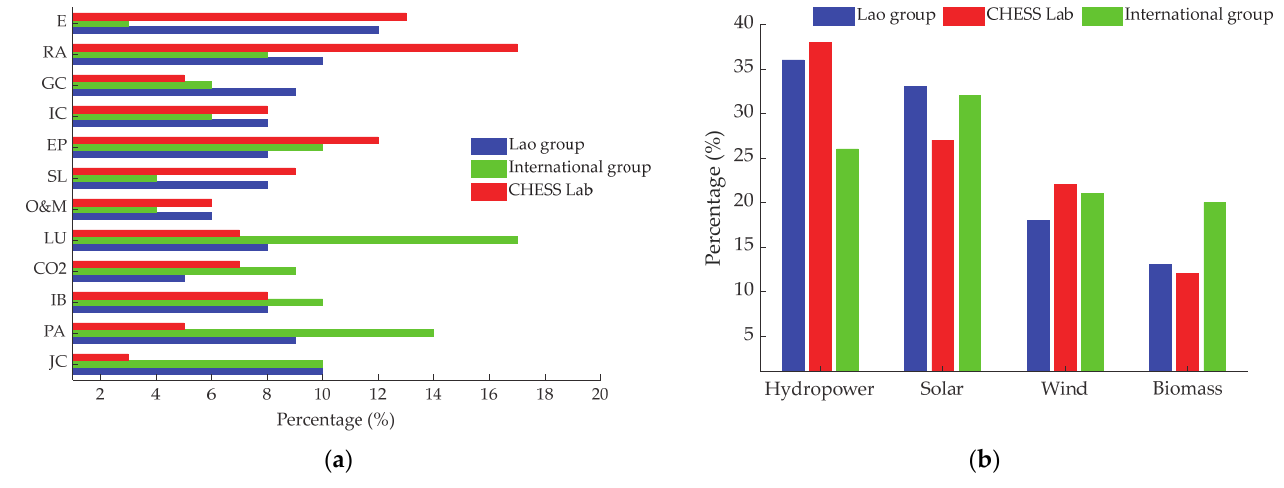
Figure 7. ( a ) Global weights of the sub-criteria of the three groups; ( b ) Relative weights of the RE alternatives of the three groups.